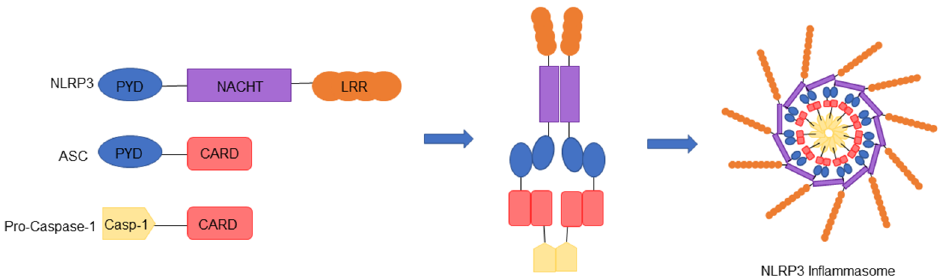
Figure 1. Assembly of the NLRP3 inflammasome. When activated, the adaptor protein (ASC) binds to NLRP3 via its pyrin (PYD) domain and creates a link to pro-caspase-1 via its CARD domain. The NLRP3 inflammasome is formed of NLRP3–ASC–pro-caspase-1 complexes interacting together to form a ring-like structure.